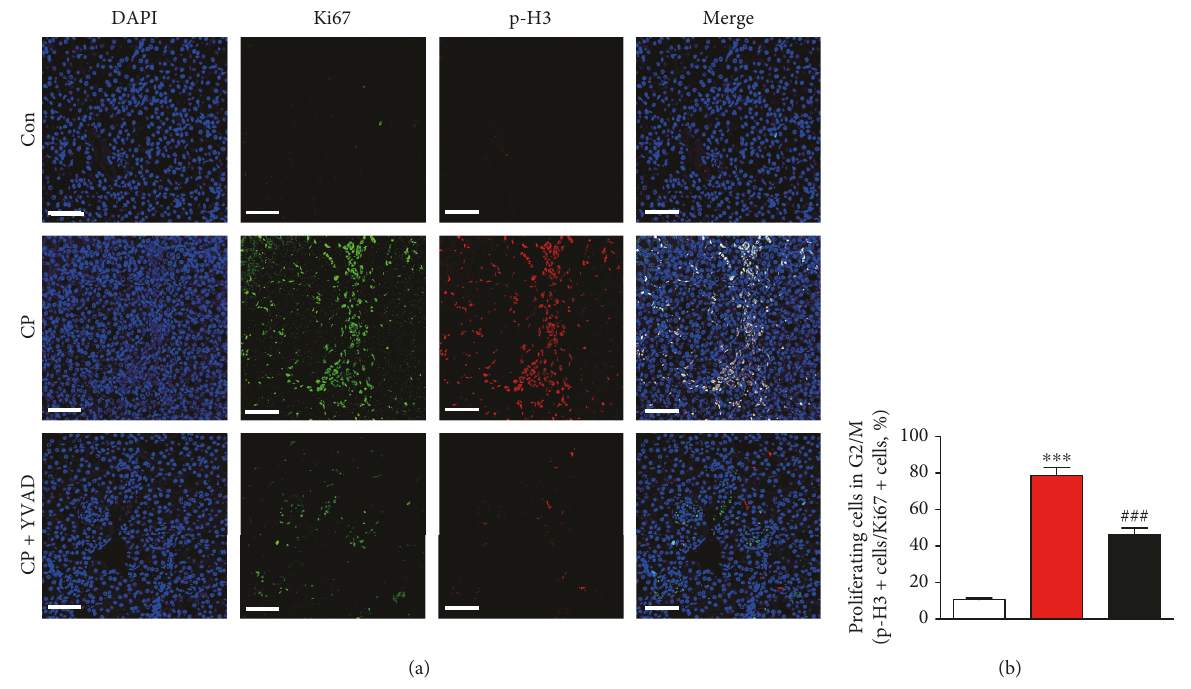
Figure 3: E ff ects of Ac-YVAD-cmk on cisplatin-induced G2/M cell cycle arrest in the kidneys. (a) Representative immuno fl uorescence staining of Ki67 (green) and p-H3 (red) on kidney sections. Nuclei were counterstained with DAPI. Scale bar: 50 μ m. (b) Percentage of cells in the G2/M phase among all proliferative (Ki67-positive) tubular epithelial cells. Con: control, CP: cisplatin, and CP+ YVAD: cisplatin plus Ac-YVAD-cmk. n = 8 per group. All data are expressed as the mean ± SEM. ∗∗ P < 0 01 and ∗∗∗ P < 0 001 vs. Con. # P < 0 05 and ### P < 0 001 vs.